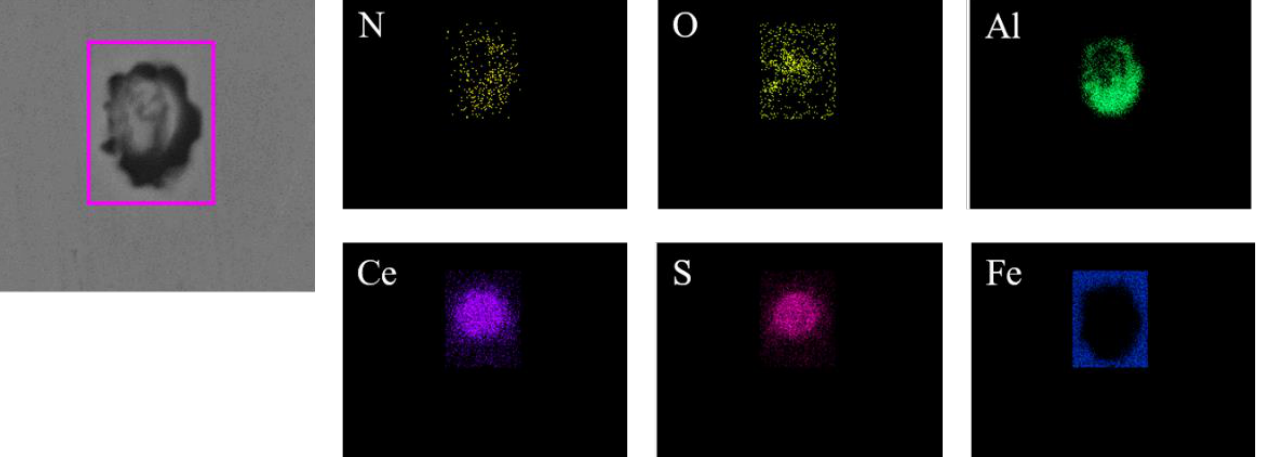
Figure 7. Elemental mapping of a typical inclusion in the steel with 20 ppm Ce content.